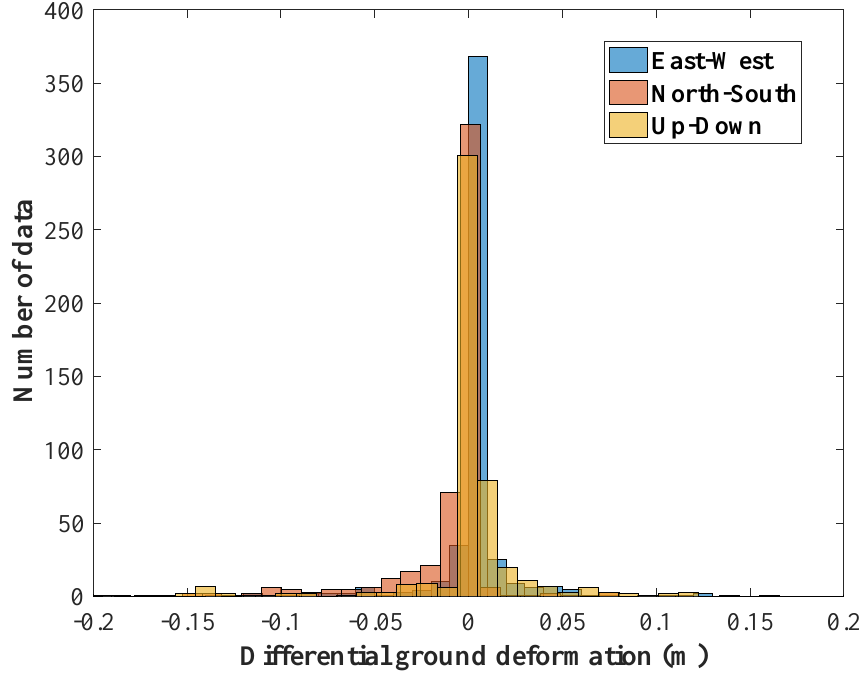
Figure 6. Histograms of differential ground deformation at the site of interest in east–west